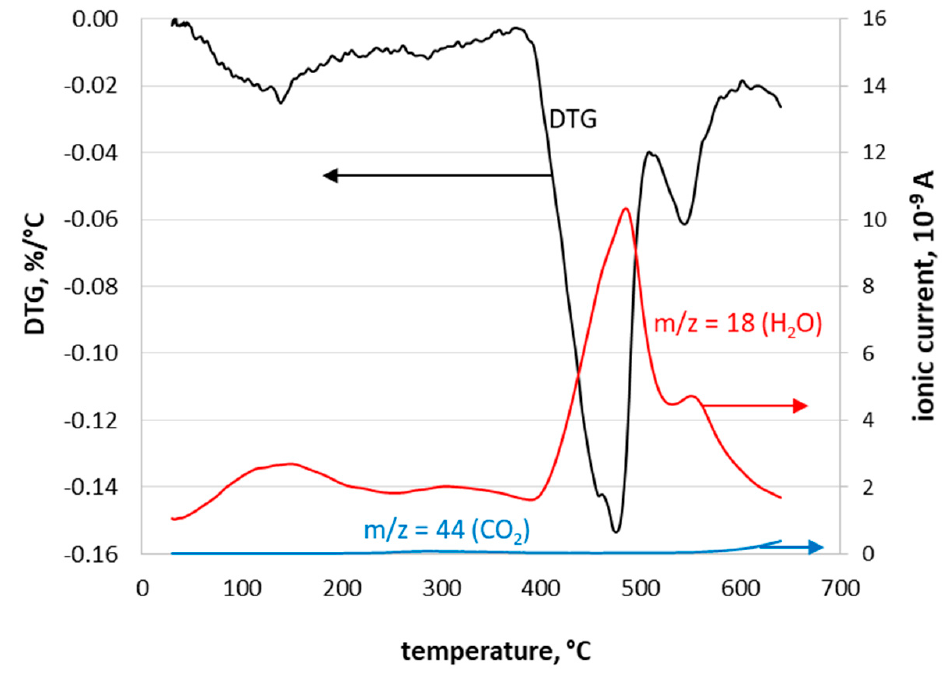
Figure 3. Differential gravimetric curve (DTG) of waste together with MS.